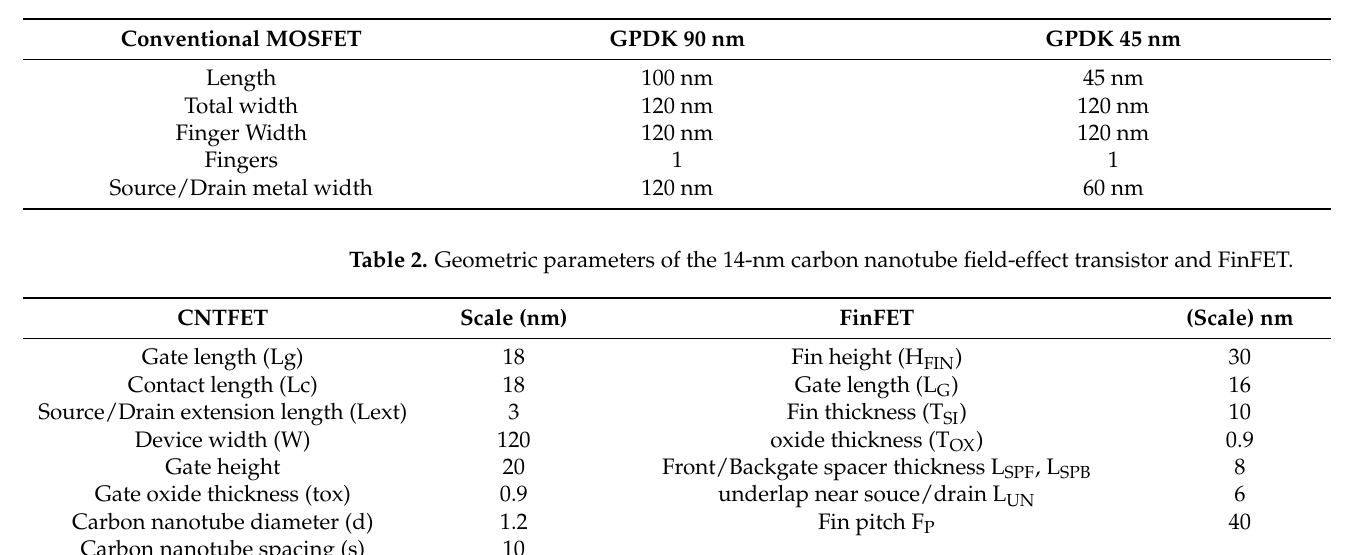
Table 1. Geometric parameters of conventional MOSFET GPDK 90 and 45 nm technology.